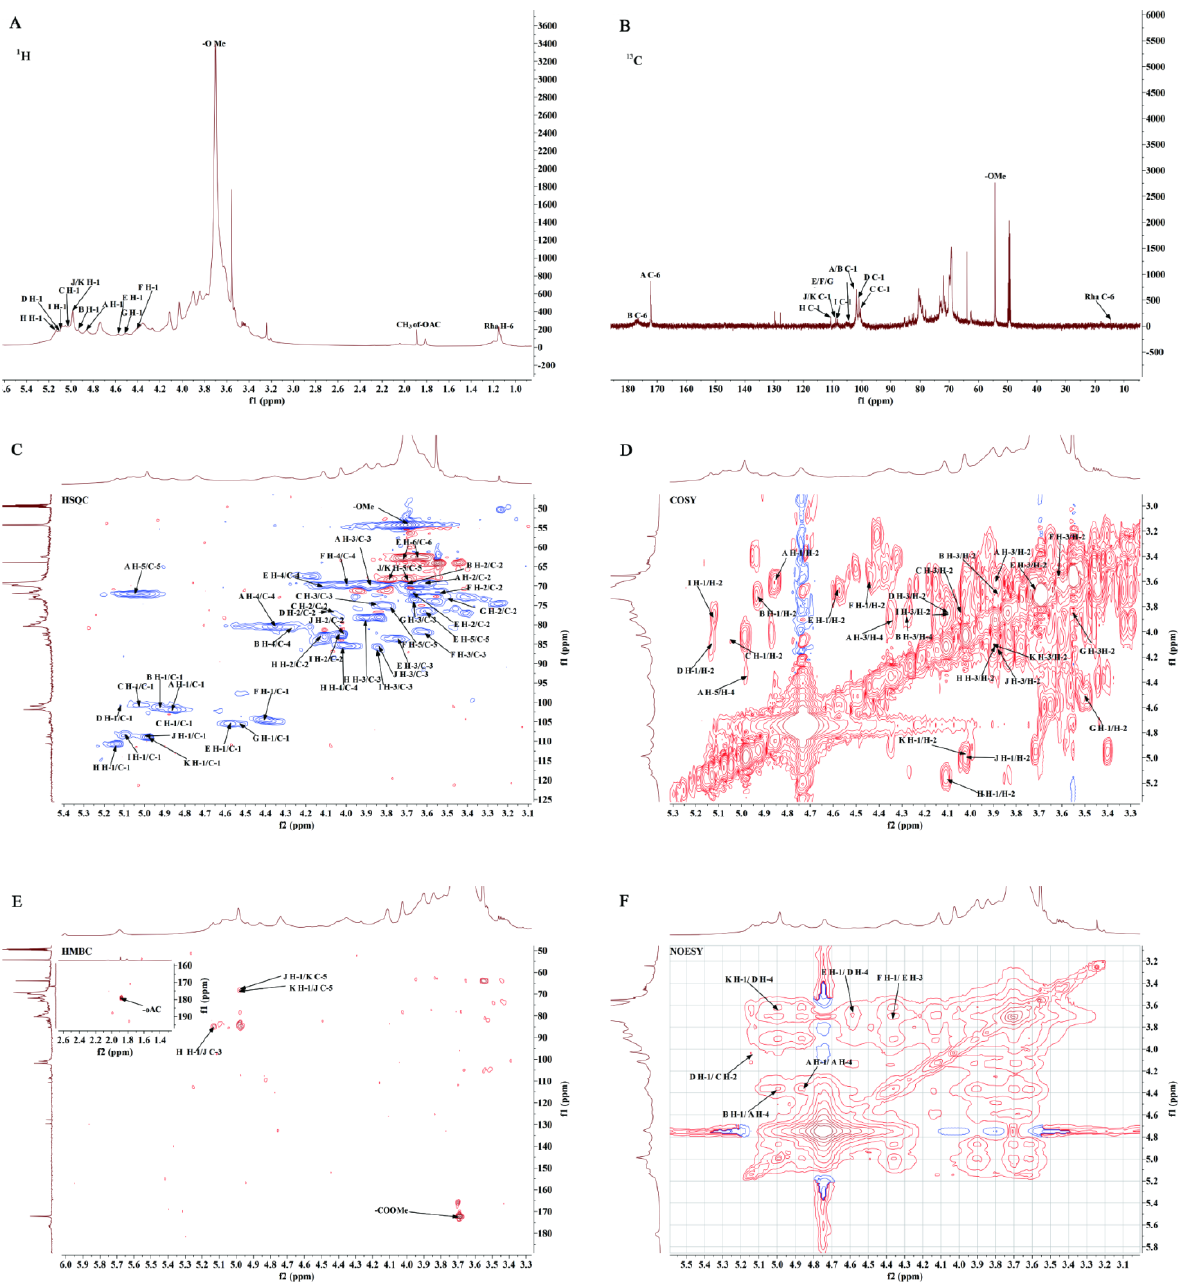
Figure 7. Nuclear magnetic resonance (NMR) spectra of GP2a. ( A ) 1 H-NMR spectrum; ( B ) 13 C-NMR spectrum; ( C ) Heteronuclear single quantum relation (HSQC) spectrum; ( D ) Correlated spectroscopy (COSY) spectrum; ( E ) Heteronuclear multiple bond correlation (HMBC) spectrum; ( F ) Nuclear Overhauser effect spectroscopy (NOESY) spectrum.